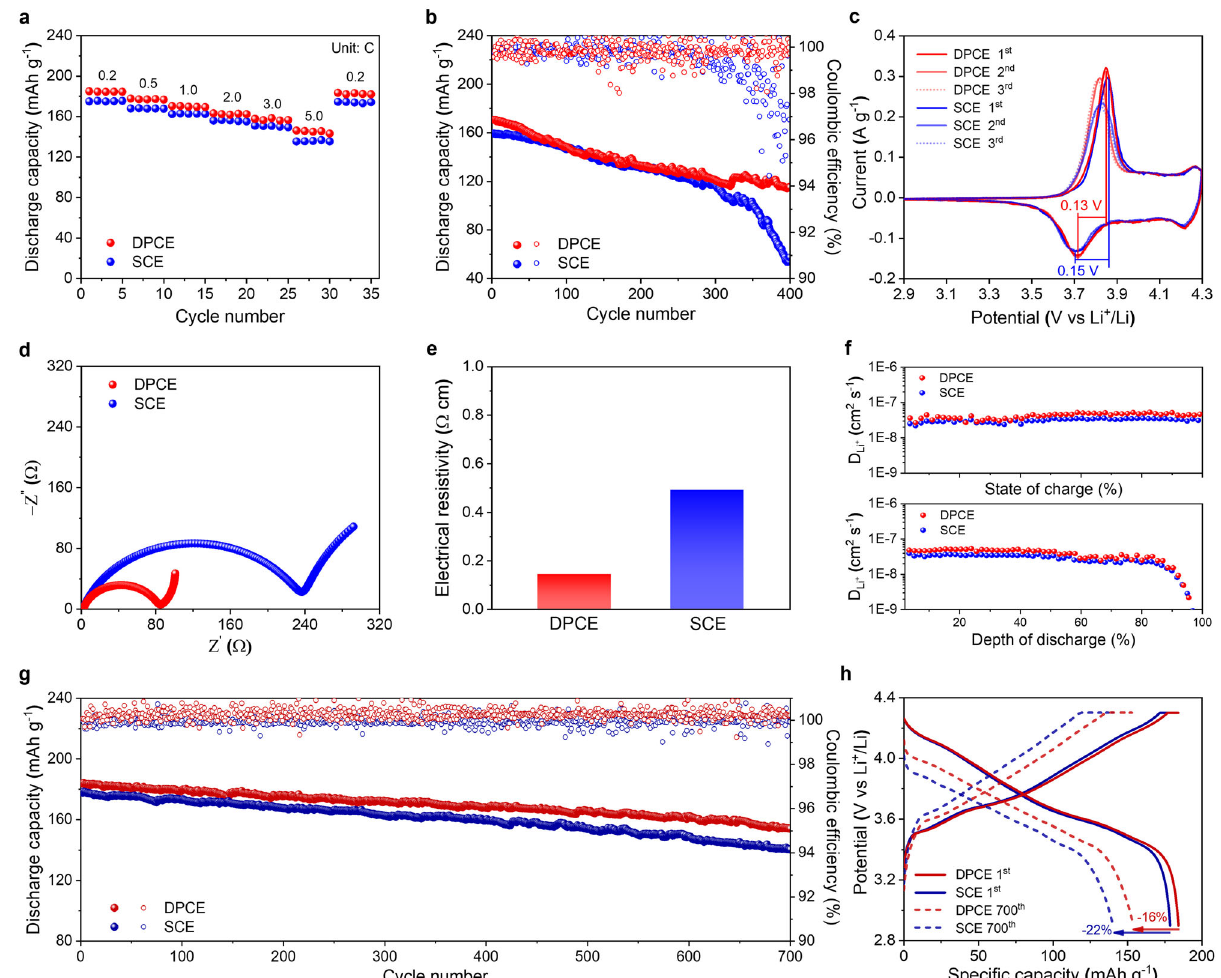
Fig. 3 | The electrochemical performance comparison of the SCE and DPCE. a Rate capability. b Half-cell cycling performance at a charge/discharge current density of 1.0/1.0C. c CV pro fi le of both electrodes at a scan rate of 0.2mVs − 1 between 2.9 and 4.3V. d Fitted Nyquist plots. e Surface electrical resistivity of the